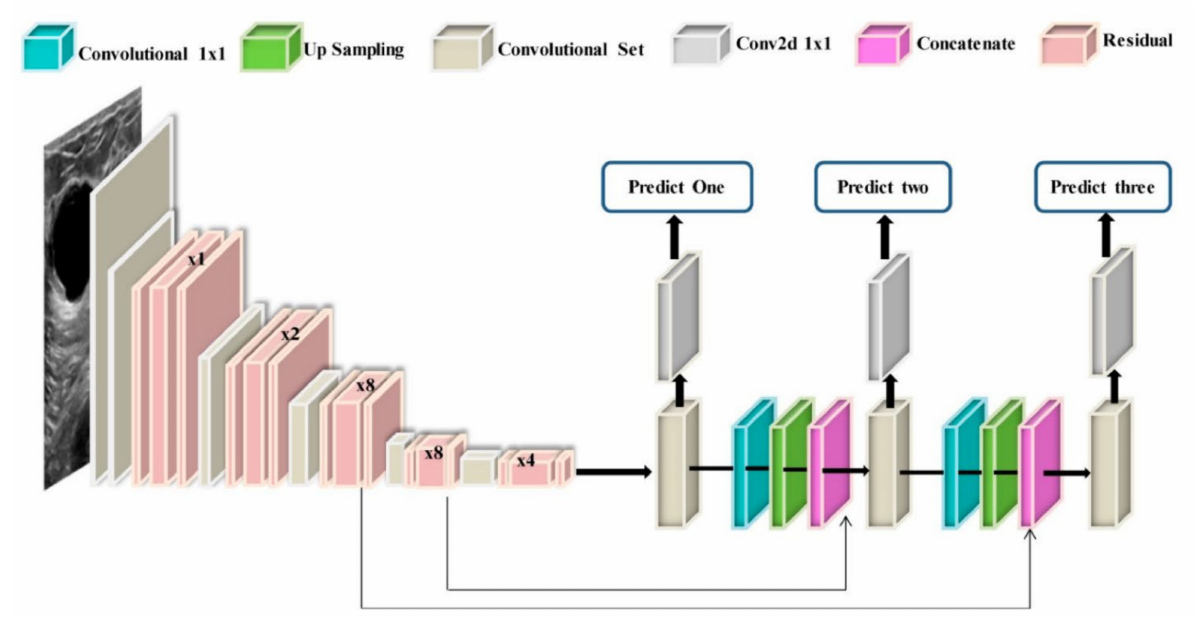
Figure 8. Example of a model architecture for breast cancer subtypes classification from US images via CNN models